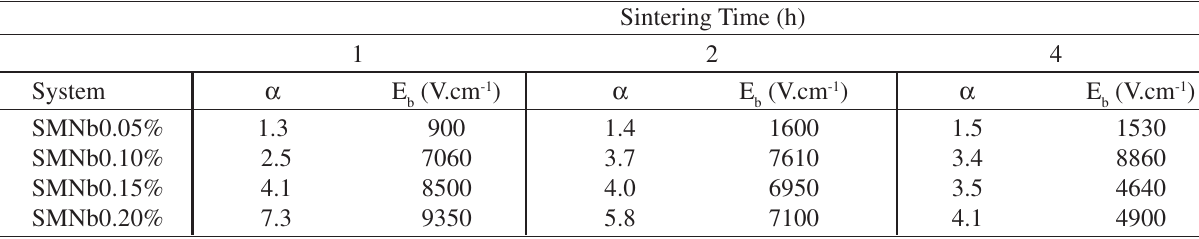
Table 2. α , E and values for the SnO b